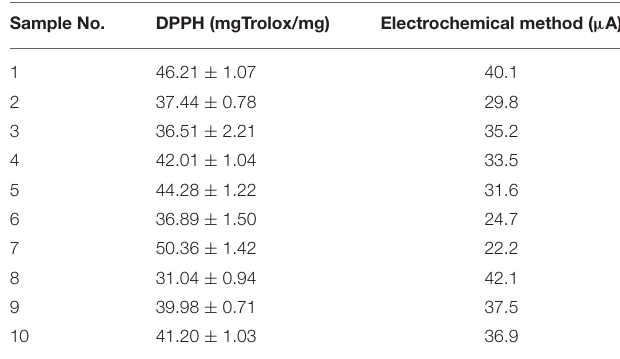
TABLE 1 | The antioxidant capacity of 10 samples of Scutellaria baicalensis detected using the DPPH method and the proposed electrochemical method. Sample